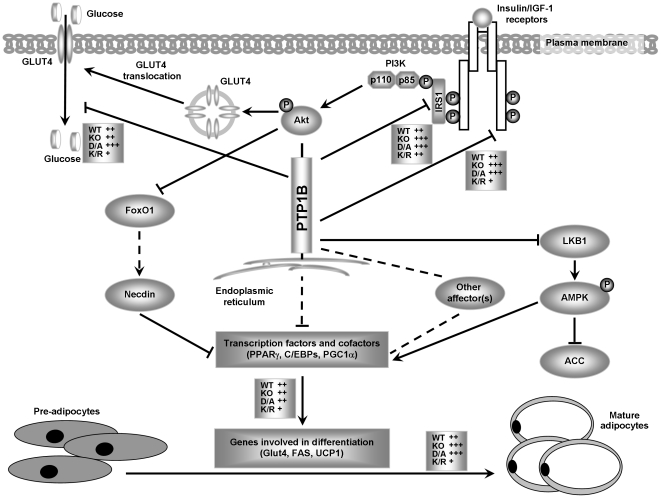
Proposed model of regulation of brown fat adipogenesis by PTP1B.PTP1B can regulate adipogenesis through insulin-dependent and insulin-independent pathways. Activation of cell surface receptors of insulin or IGF1 leads to phosphorylation of IRS proteins, activation of PI3K and MAPK pathway, and glucose uptake. Alterations in downstream signaling (summarized in Tseng et al.
[23], [40]) lead to the initiation of transcriptional cascades that involve PPARγ, C/EBPs, and PGC1α and cause changes that are required for differentiation of brown adipocytes (expression of Glut4 and UCP1). PTP1B dephosphorylates IR and IRS1 in differentiated brown adipocytes and modulates insulin-stimulated glucose uptake. In addition, PTP1B regulates LKB1/AMPK signaling pathway in differentiated brown adipocytes. Conceivably, PTP1B also could modulate other affector(s) of cellular signaling to regulate transcription factors and cofactor to influence differentiation. Effects of KO, D/A and K/R on adipose differentiation, IR and IRS1 tyrosyl phosphorylation, glucose uptake, and LKB1/AMPK signaling are summarized. Alterations in KO, D/A and K/R are indicated with the symbol (+) and compared with WT (set at ++). Arrows indicate activation and T-shaped lines indicate repression. A dashed line indicates that the connection has not been completely established.